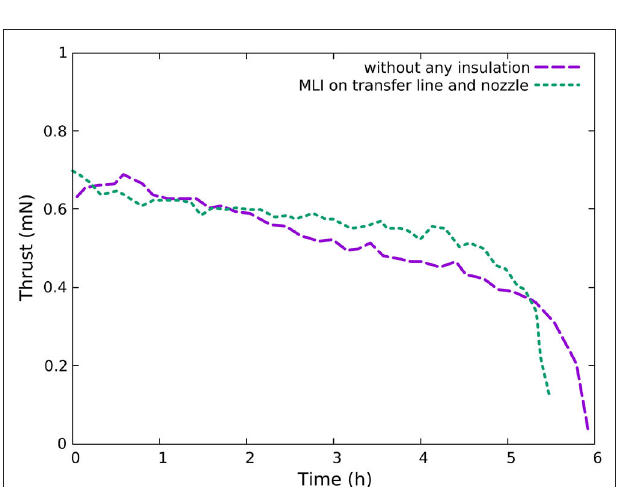
FIGURE 6 | Measured thrust vs. time. Thruster was configured for 12 s burns every minute, at 70 ◦ C reservoir temperature. The reservoir was loaded with 10 g of naphthalene at the beginning of the run and was operated continuously until the propellant was fully exhausted. The purple dashed line was obtained with no insulation on the transfer line and nozzle and the green dotted line was obtained after insulating the transfer line and nozzle with multi-layer insulation (MLI), as discussed in section